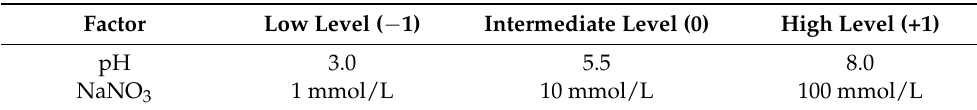
Table 1. Levels of parameters used in the 3 2 full factorial